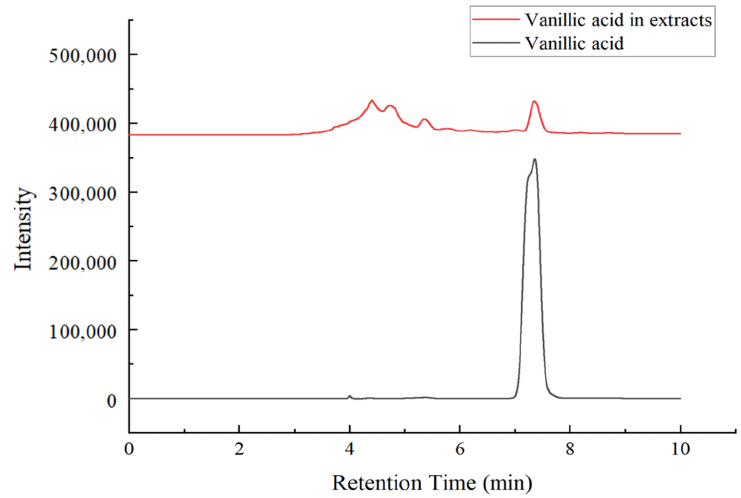
Figure 3. The qualitative and quantitative results of Amomum villosum vanillic acid by high-perfor- mance liquid chromatography–diode array